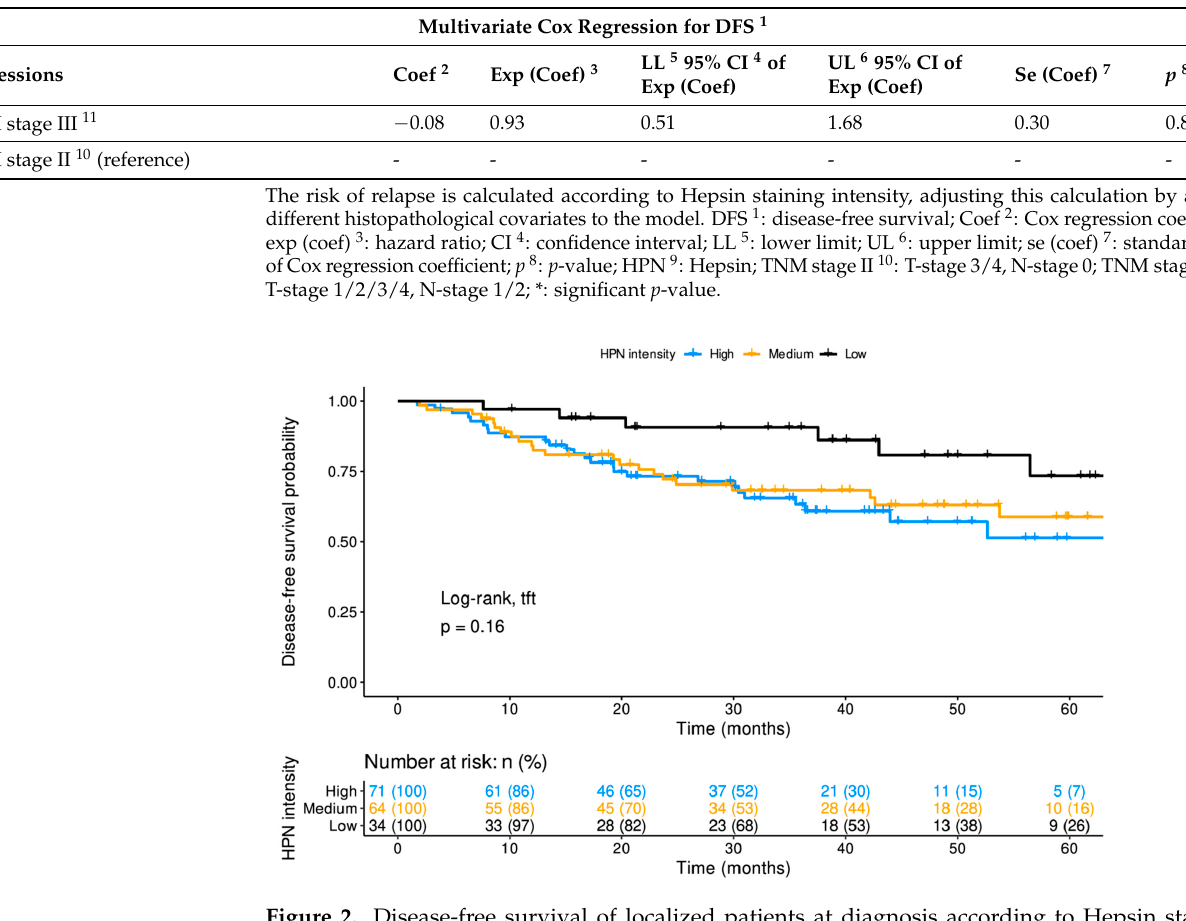
Figure 2. Disease-free survival of localized patients at diagnosis according to Hepsin staining. Disease-free survival is shown for the three groups of patients with different hepsin levels at diagnosis. Time on the X-axis corresponds with months of follow-up since diagnosis. The Log-rank test for trends gives information on the degree of significance of the differences between the three groups of patients. At the bottom, the patients who may suffer metastatic relapse after a given time from the start of follow-up are shown. p : p -value; tft: test for trends; HPN: Hepsin; n (%): number of patients (percentage). Table 2. Multivariate Cox regression model for disease-free survival in localized patients at diag- nosis. Multivariate Cox Regression for DFS 1